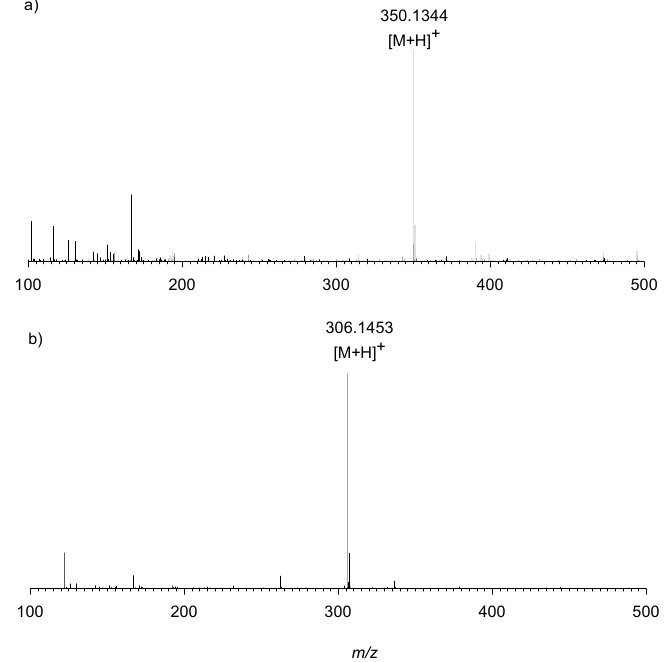
Figure 9. HRMS spectrum obtained by direct infusion of ( a ) d 1RR and ( b ) sample 1 on an LTQ Orbitrap XL™ Hybrid FT Mass Spectrometer.